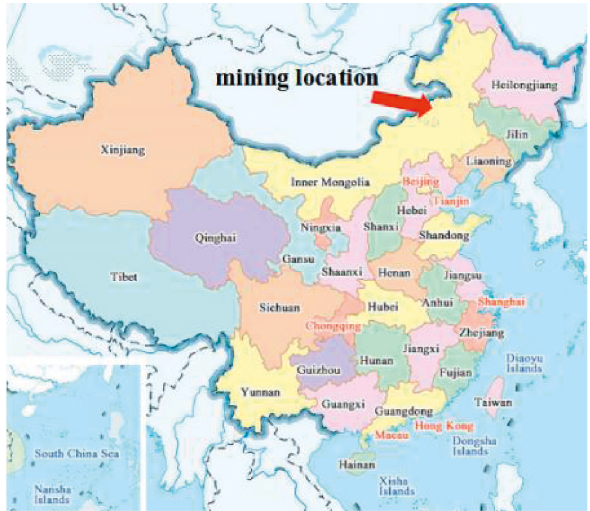
Figure 1: Geographical location of the mining